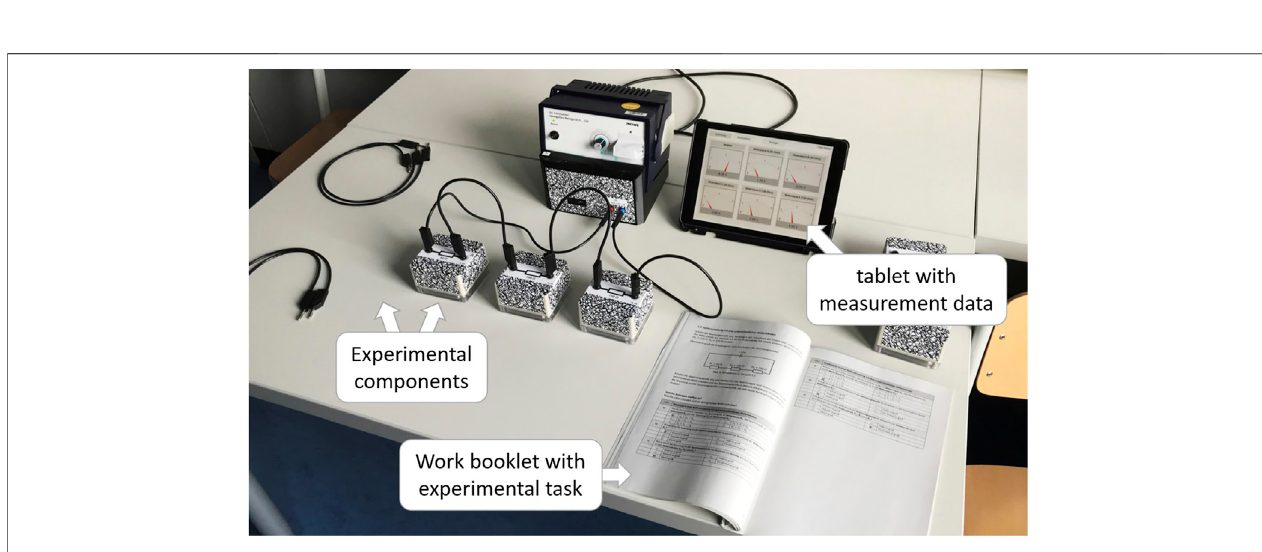
FIGURE 2 | The learning environment as experienced by group 1 (presentation of the measurement data via separate display on a tablet).